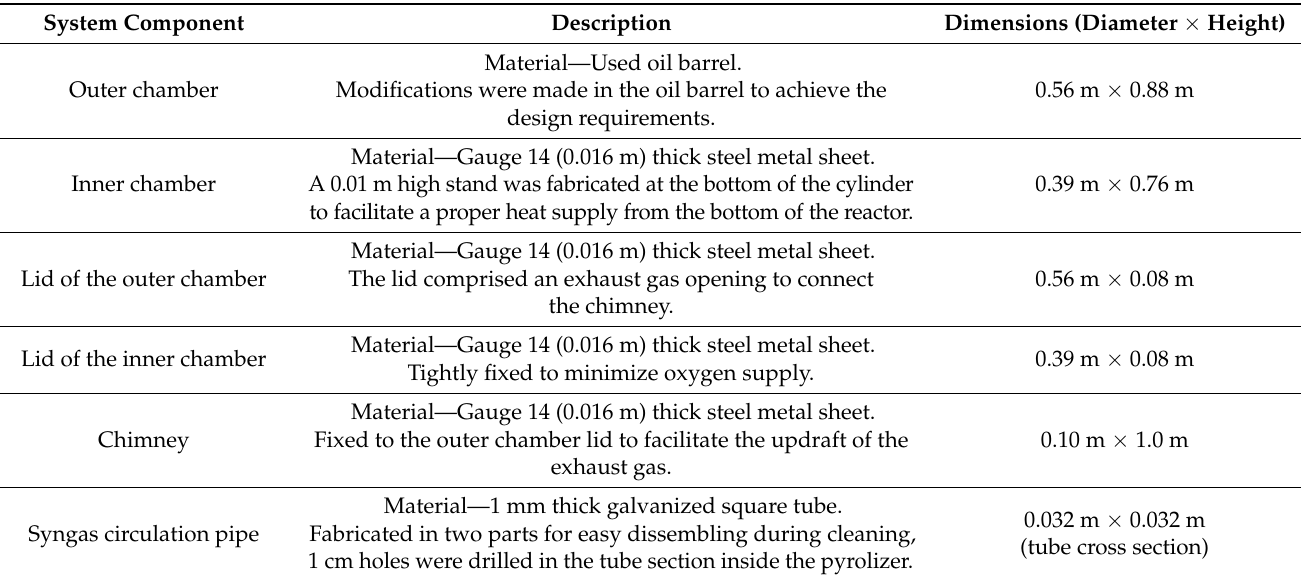
Figure 3. Image of the fabricated dual-chamber reactor: ( a ) actual reactor, ( b ) 3D model of the reactor. Table 2. Specifications of the dual-chamber